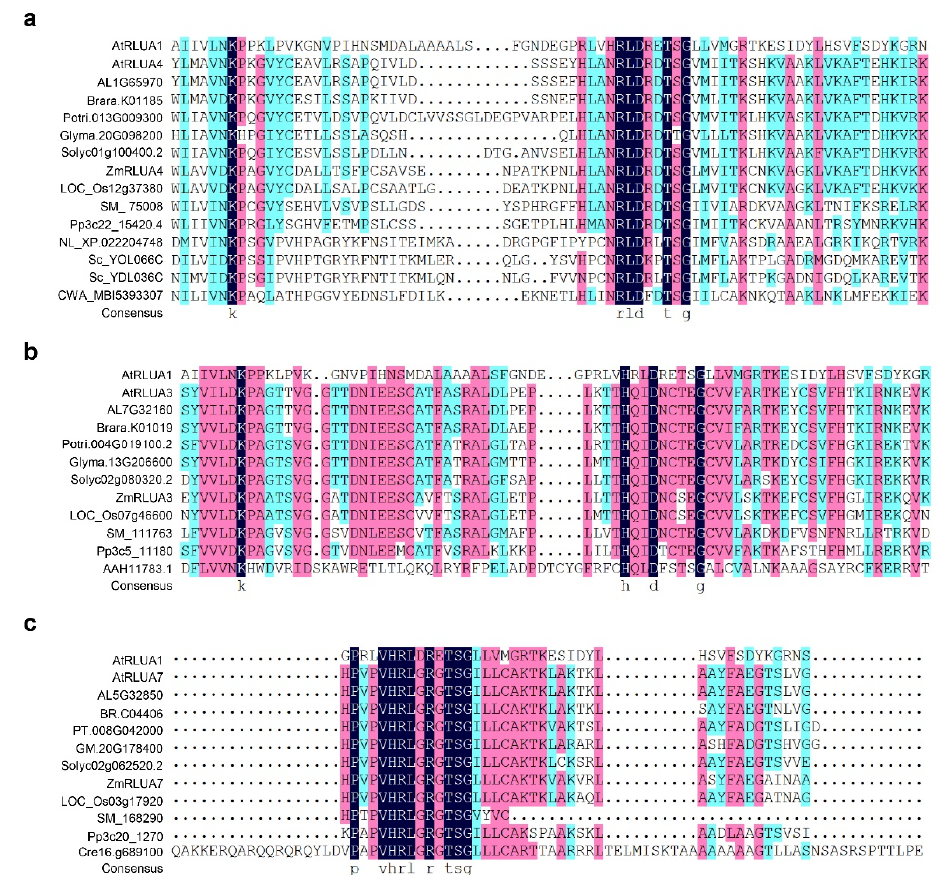
Figure 5. Non-canonical catalytic motif in plant PUS proteins. ( a ) Sequence alignment for the XXNRLD-type catalytic motif of PUS proteins from different species. ( b ) Sequence alignment for the XXHQID-type catalytic motif of PUS proteins from different species. ( c ) Sequence alignment for the XXHRLG-type catalytic motif of PUS proteins from different species. The XXHRLD-type canonical catalytic motif of PUS proteins from A. thaliana and E. coli , the XXHQID-type of PUS proteins from H. sapiens were included for alignment control, respectively. At, Arabidopsis thaliana ; AL, Arabidopsis lyrata ; Brara, Brassica rapa ; Potri, Populus trichocarpa ; Glyma, Glycine max (Linn.) Merr ; Solyc, Solanum lycopersicum ; Zm, Zea mays ; LOC_Os, Oryza Sativa ; Sm, Selaginella moellendorffii ; Pp, Physcomitrella patens ; Cre, Chlamydomonas reinhardtii ; Sc, Saccharomyces cerevisiae ; NL, Nilaparvata lugens ; Hs, Homo sapiens ; CWA, Candidatus Woesearchaeota archaeon